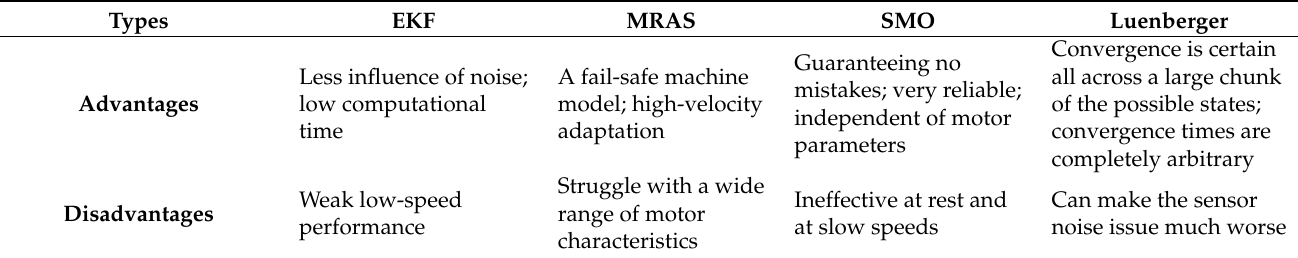
Table 2. Comparison of position observers.